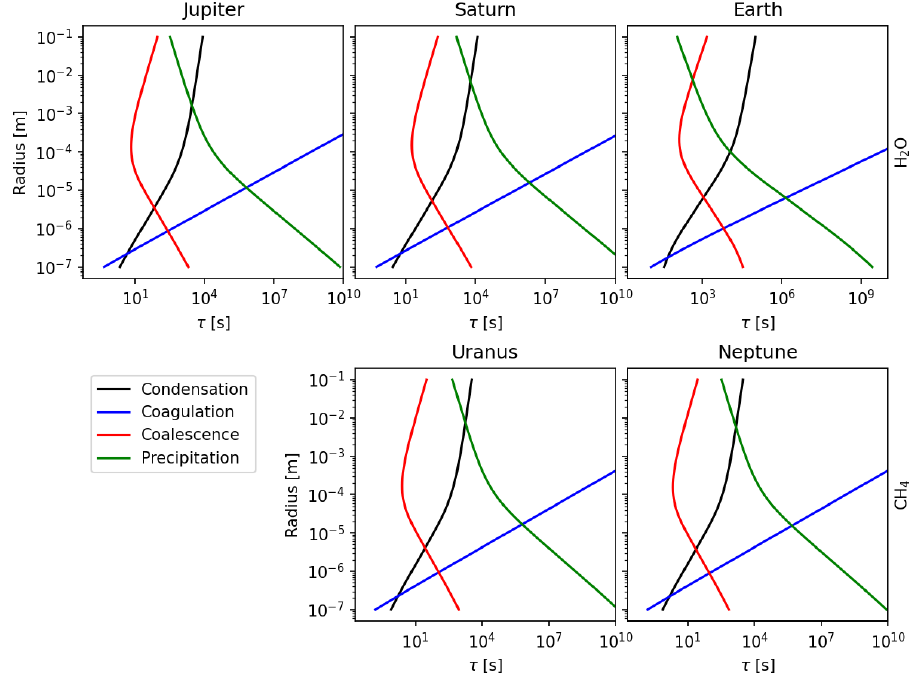
Figure 10. Characteristic timescale ( τ ) for creating a particle of a given radius from different processes for water ice on Jupiter, Saturn and Earth and methane ice on the ice giants. The ‘falling’ timescale relates to the time taken for a particle of a given radius to fall one scale height. The fastest processes (left of edge of the lines) dominate for a particle at any given process. Cloud growth is inhibited when precipitation (given by the falling timescale, green curves) is comparable to the formation timescales (e.g., at ∼ 1 cm particles on Jupiter, Saturn and